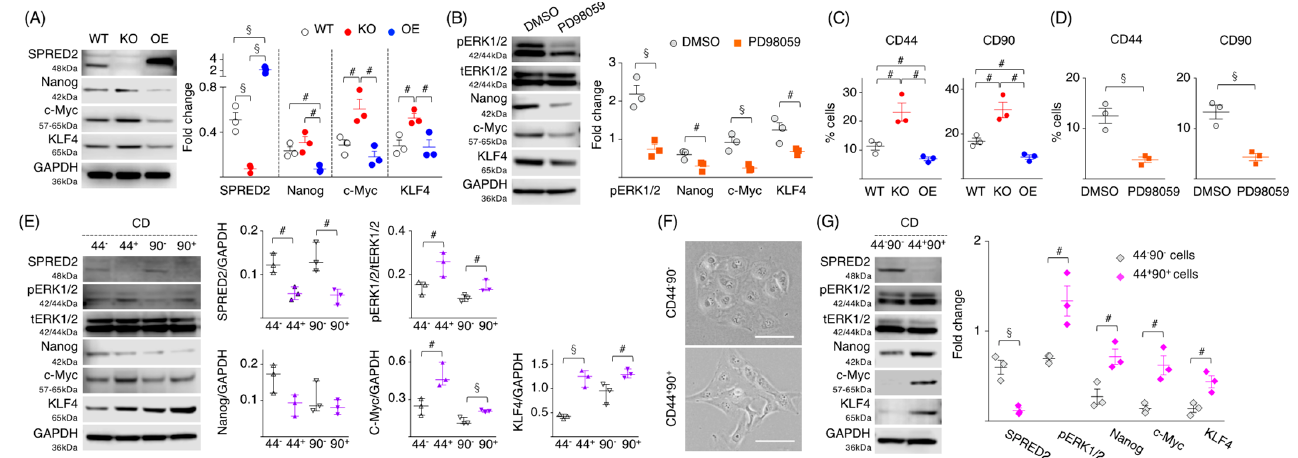
Figure 4. SPRED2 affects the expression of stemness markers. ( A ) Cell extracts were prepared, and the presence of each protein was evaluated by western blotting. Band densities were digitized and semi-quantitated ( n = 3, each). ( B ) HepG2 cells were treated with 20 µ M PD98059 or vehicle (DMSO) for 24 h, cell lysates were prepared, and the presence of each protein was evaluated by western blotting. Band densities were digitized and semi-quantitated ( n = 3, each). ( C ) Cells were stained with Alexa Fluor 488-conjugated anti-human CD44 antibody or anti-human CD90 antibody, and the percentage of positive cells was analyzed by flowcytometry ( n = 3, each). ( D ) HepG2 cells were treated with 20 μ M PD98059 or vehicle (DMSO) for 24 h in standard culture conditions and stained with Alexa Fluor 488-conjugated anti-human CD44 antibody or anti-human CD90 antibody, and the percentage of CD44 or CD90 positive cells was analyzed by flowcytometry ( n = 3, each). ( E ) CD44 + and CD90 + cells were isolated from HepG2 cells by using CD44 and CD90 microbeads. Cell lysates were prepared, and the presence of each protein was evaluated by western blotting. Band densities were digitized and semi-quantitated ( n = 3, each). ( F , G ) CD44 − CD90 − and CD44 + CD90 + cells were isolated from HepG2 cells by using CD44 and CD90 microbeads. ( F ) Representative cell morphology is shown. Scale bars: 50 μ m. ( G ) Cell lysates were prepared, and the presence of each protein was evaluated by western blotting. Band densities were digitized and semi-quantitated ( n = 3, each). # p < 0.05, § p < 0.01, two-tailed unpaired t test.